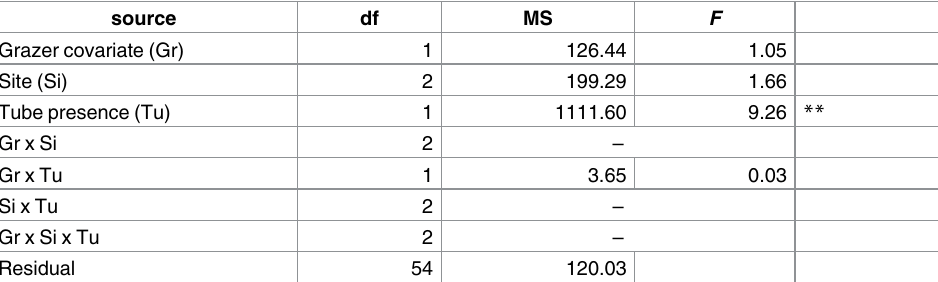
Table 1. Amounts of Ulva algae differ significantly between boulders with vs without worm-tubes. source df MS F Grazer covariate (Gr) 1 126.44 1.05 Site (Si) 2 199.29 1.66 Tube presence (Tu) 1 1111.60 9.26 ** Gr x Si 2 – Gr x Tu 1 3.65 0.03 Si x Tu 2 – Gr x Si x Tu 2 – Residual 54 120.03 Analysis was done with PERMANOVA using Euclidean distances [48]. Comparisons were of percentage cover of Ulva spp. on boulders with and without the presence of serpulimorph tubes from three random sites and with the density of all grazers as covariate. Eliminated interaction terms ( P > 0.25) are denoted by “–”; n =